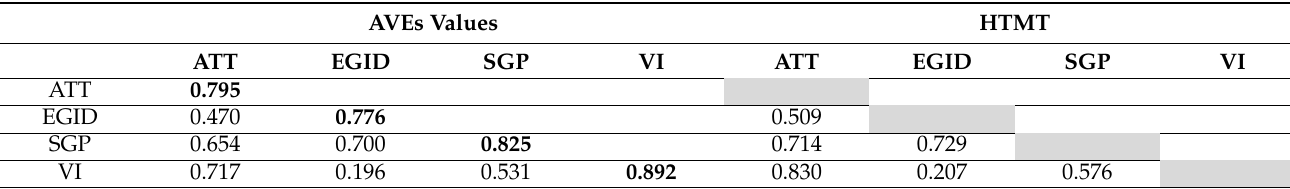
Table 3. AVEs values and HTMT results.